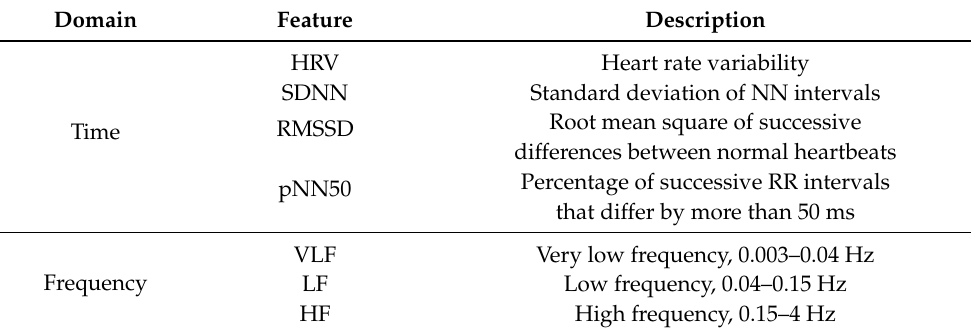
Table 5. Common features obtain from ECG